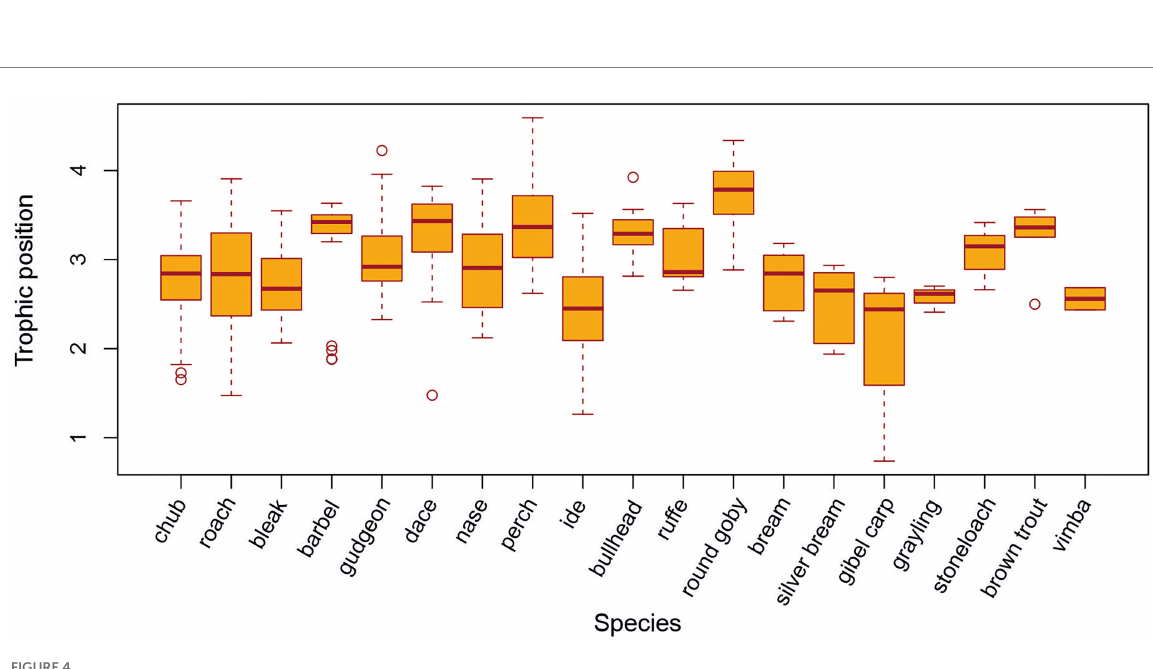
FIGURE 4 Trophic position of fish species across sampling sites.